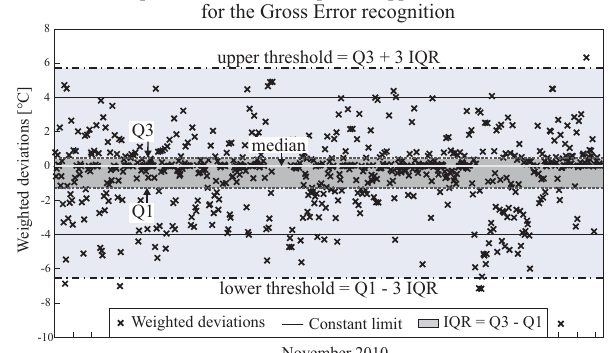
Fig. 8. Weighted deviations (black crosses) for 2 e of an exemplary station for November 2010. These constitute the basis for the com- putation of a variable station specific lower ( L 1 ) and an upper ( L 2 ) limit (black dash dotted lines), which support the gross error recog- nition. Q 1 and Q 3 denote the first and third quartiles (dark gray dashed lines) and IQR the interquartile range ( Q 3 − Q 1 , dark gray area). Additionally to the variable limits, constant values (thin solid black lines) of ± 4 ◦ C have to be exceeded in order to recognize an observation as a gross error. In December 2010, all observations with weighted deviations outside the interval [ L 1 , L 2 ] (light gray area) would be identified as gross